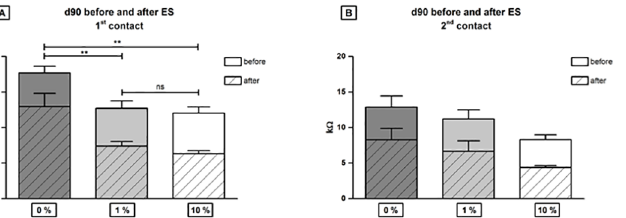
Fig 5. Impedances of contact one (A) and contact two (B) in all three treatment groups before (clear) and after (dashed) electrical stimulation on experimental day 91. At contact one (A) in both DEX treated groups impedances were significantly reduced after 3 month observation time compared to the group receiving 0% DEX ( ** = p < 0.01) and there was no difference between impedance levels in 1% DEX or 10% DEX treated individuals detected at contact one (ns = not significant). At the second contact, which was located more apical in the cochlea, no significant differences in impedance values between treatment groups were detected (B). Error bars = SEM.